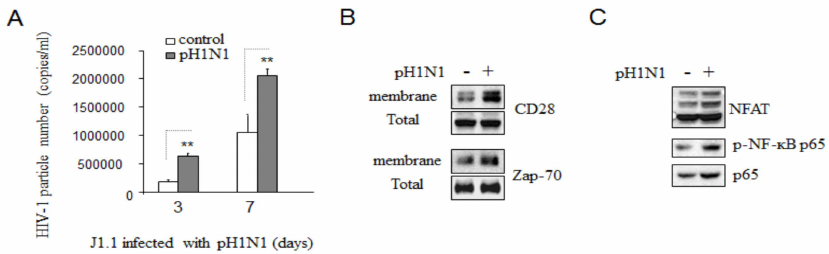
Figure 5. Pandemic influenza A (H1N1) virus infection can reactivate HIV-1 replication from its latent infections. J1.1 cells were infected with pH1N1, stock A/California/04/2009, and cultured for 3 days. ( A ) 140 µ L of culture supernatants containing HIV-1 particles were used to isolate viral RNA. 10 µ L in 50 µ L of the RNA was used as template to perform real-time PCR. Known concentration of HIV-1 (MN) viral RNA (serially diluted: 10 8 to 100 copies) were used as templates and quantitative